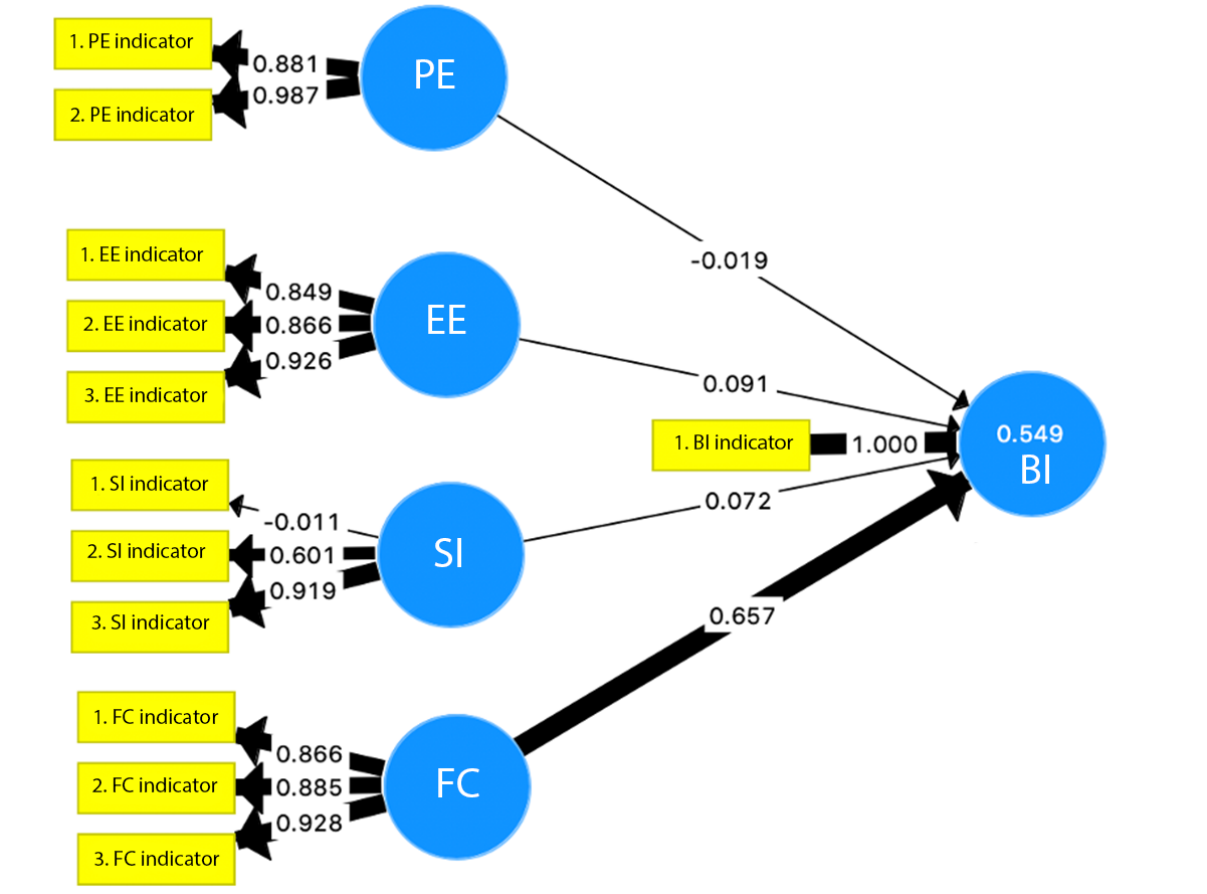
Figure 3. Path analysis model of the Unified Theory of Acceptance and Use of Technology for predicting BI. Facilitating conditions is the largest predictor of BI (path coefficient=0.657; R2=0.549). The thicker the arrow, the larger the effect on the variable or construct in the measurement or